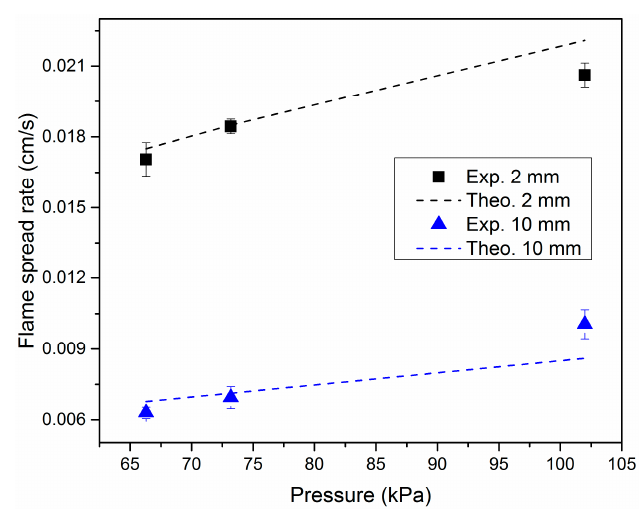
Figure 6. Comparisons between experimental and theoretical flame spread rates over 2, 10 mm slabs under three different pressure environments.